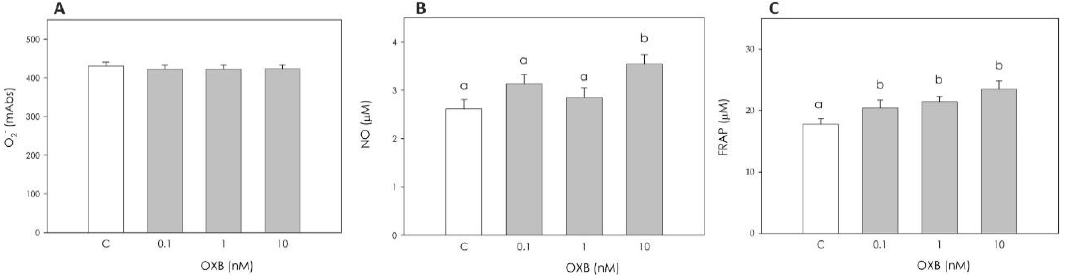
Figure 4. Effect of the 48 h treatment with orexin B (OXB; 0.1, 1 and 10 nM) on swine granulosa cell superoxide anion generation (O 2− ) using WST assay ( A ), nitric oxide (NO) production using Griess assay ( B ) and non-enzymatic scavenging activity using FRAP assay ( C ). Data, expressed as milliAbsorbance (mAbs), represent the mean ± SEM of six replicates/treatment repeated in five different experiments. In each panel, different letters on the bars indicate a significant difference ( p < 0.05) among treatments as calculated by ANOVA and Scheffè’s F test.